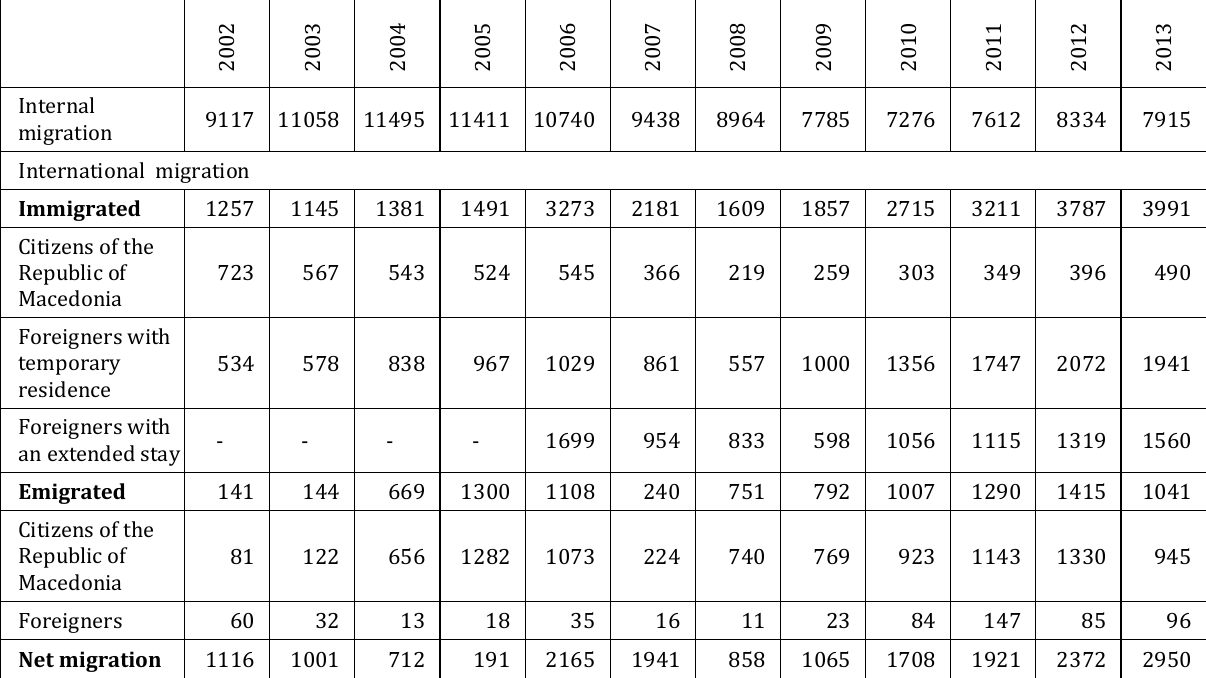
Table 1. Migration movements of the population of the Republic of Macedonia in the period 2002-2013 (source of data: